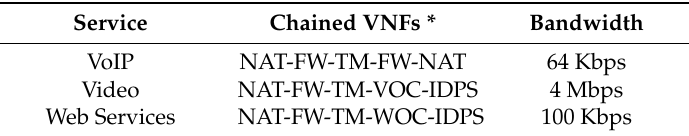
Table 2. Requirements of the deployed service chains [13,23].